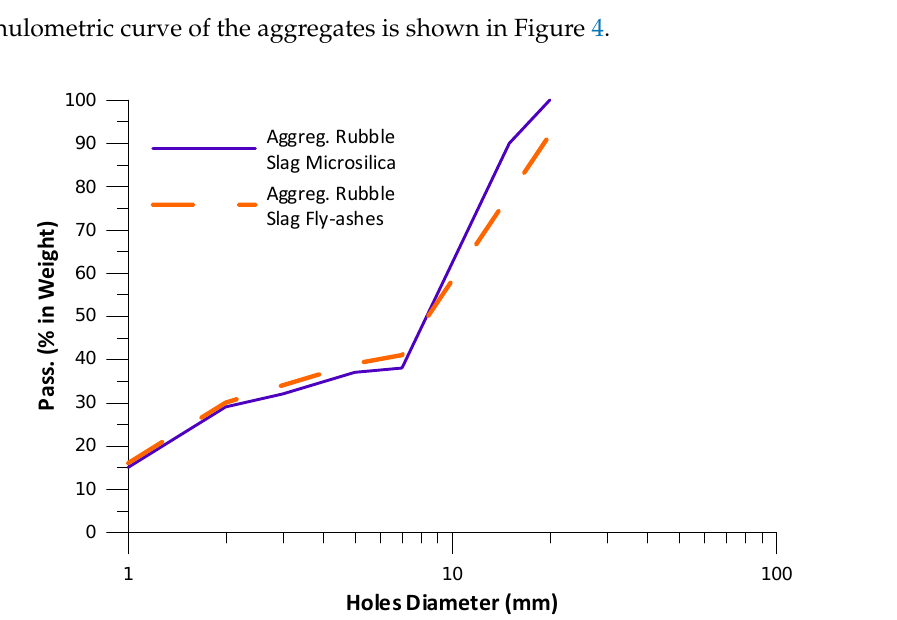
Table 2. Composition of slag and fly ashes (FA) concrete mix per unity of volume and ratios of the components.